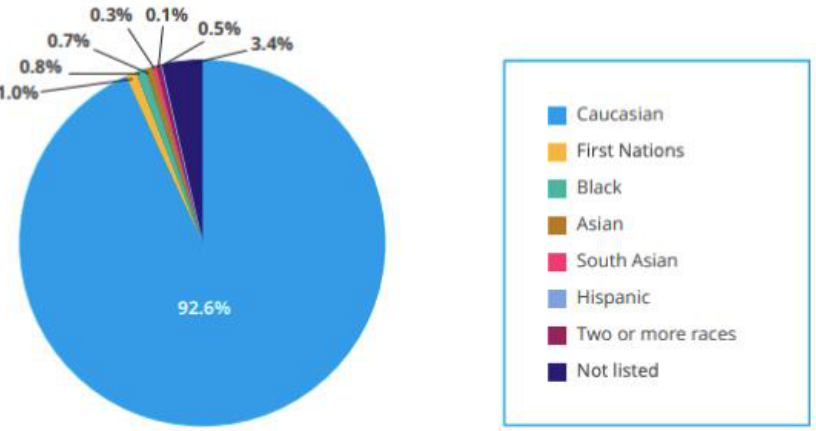
Figure 1. Ethnic distribution of the CF population, taken from the 2018 Canadian CF Registry Annual Data Report [16].